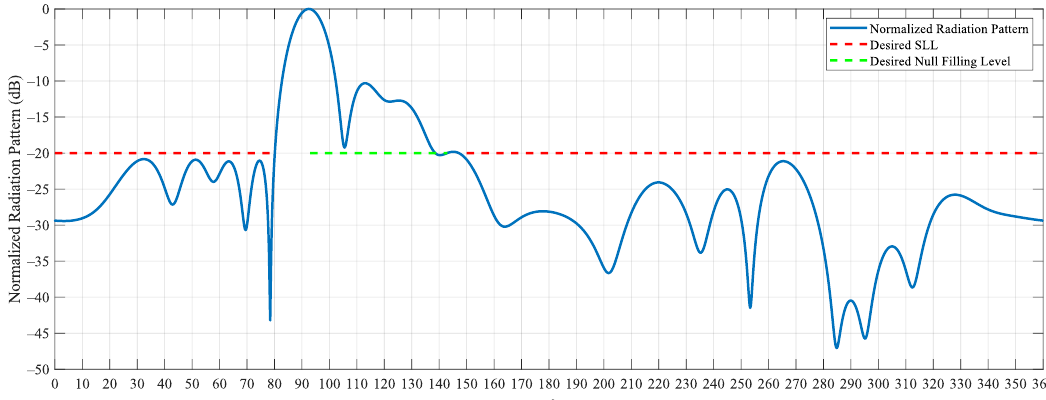
Figure 3. Normalized radiation pattern versus elevation angle θ at azimuth angle φ = 0. The maximum value of the normalized radiation pattern (0 dB) corresponds to the actual maximum gain of the AMAA 13.9 dBi at θ = 93 ◦ (main lobe tilting by 3 ◦ ). The red dash-line shows the desired SLL outside the service area, and the green dash-line shows the desired null filling level inside the service area. The optimal radiation pattern should be below the red dash-line and above the green dash-line.